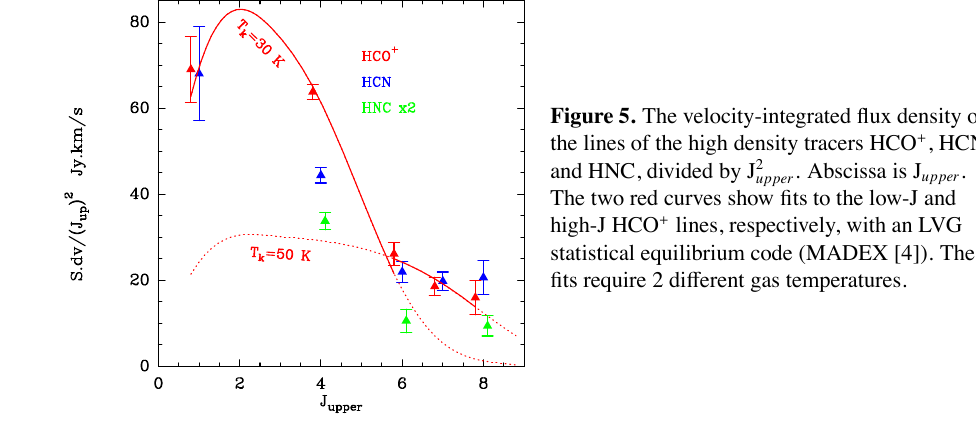
Figure 5. The velocity-integrated flux density of the lines of the high density tracers HCO + , HCN and HNC, divided by J 2 upper . Abscissa is J upper . The two red curves show fits to the low-J and high-J HCO + lines, respectively, with an LVG statistical equilibrium code (MADEX [4]). The fits require 2 di ff erent gas